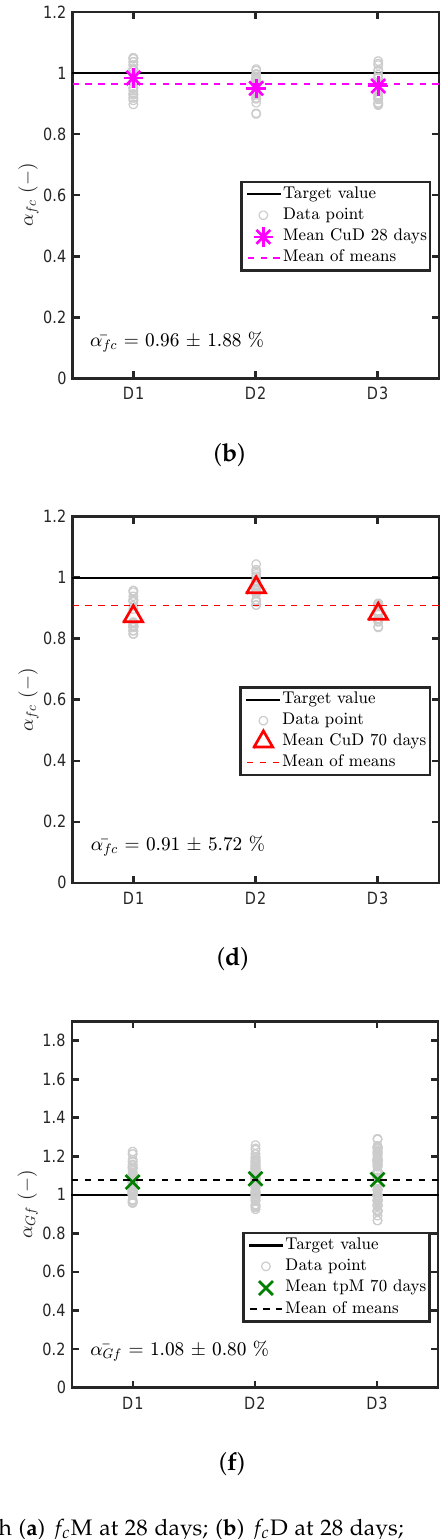
Figure 6. Combinations results of α using Equation (5) with ( a ) f c M at 28 days; ( b ) f c D at 28 days; ( c ) f c M at 70 days; ( d ) f c D at 70 days, and using Equation (6) with ( e ) G F and ( f ) G f both at 70